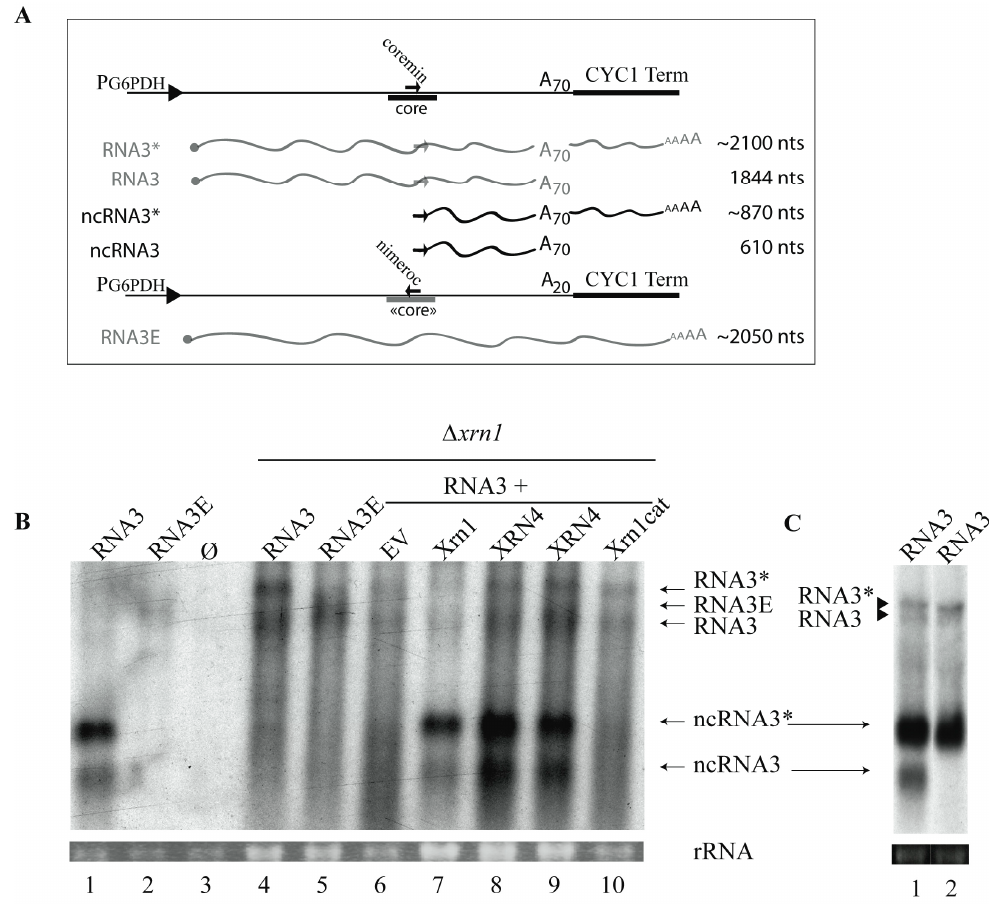
Figure 1. Exoribonucleases are responsible for noncoding RNA3 species accumulation in Saccharomyces cerevisiae . ( A ) Representation of the expression vector cassettes (solid lines) used to produce RNA3 and RNA3E species under the control of constitutive G6PDH promoter (black arrowhead). Capped ( • ) full-length RNAs and ncRNA species are depicted by waved grey and black lines, respectively. Wild-type (wt) ‘core’ sequence is presented in dark and mutated “core” in grey bold lines. The “coremin” motif and its antisense orientation, “nimeroc”, are depicted by black sense and antisense arrows, respectively. Drawings are not to scale and for a better representation of RNA3 species, refer to figure 2 of reference [27]. RNA sizes are presented on the right; ( B , C ) Northern blot analyses of RNA3 and ncRNA species produced in yeasts; ( B ) vectors producing wt RNA3, mutated RNA3E, or control vector (Ø) were introduced in S. cerevisiae (lanes 1–3) or Xrn1 defective strain ( Δ xrn1 ) (lanes 4–5). Expression of RNA3 (lanes 6–10) was performed in ∆ xrn1 strain together with an